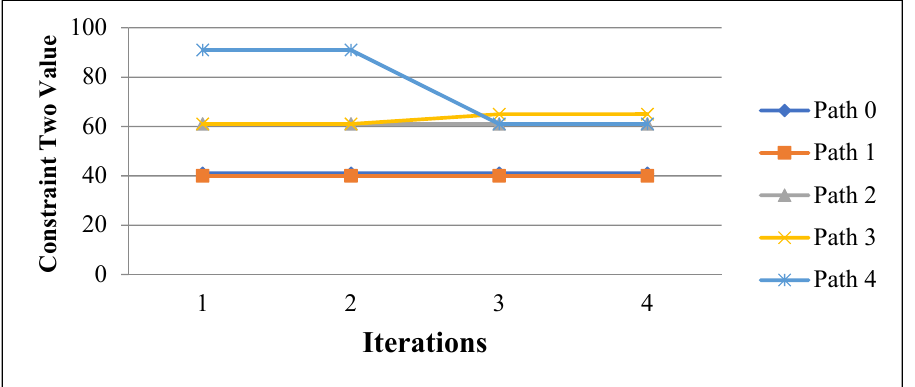
Figure 10. Constraint one of feasible paths.